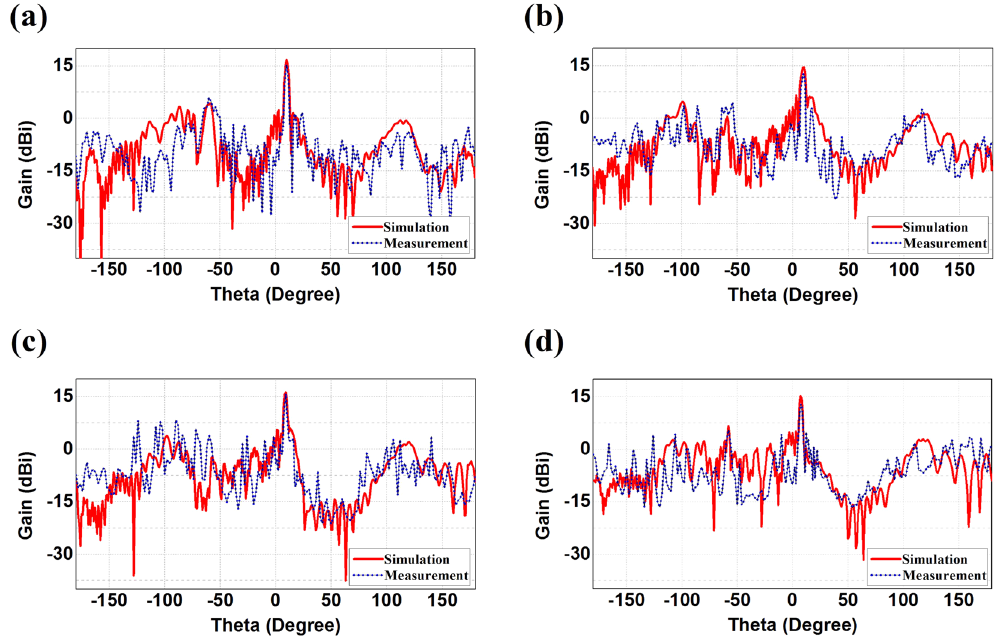
Figure 9. Comparisons of the measured radiation patterns and the simulation results of the dual reflecting system. ( a ) 15 GHz, ( b ) 15.3 GHz, ( c ) 15.5 GHz, and ( d ) 15.7